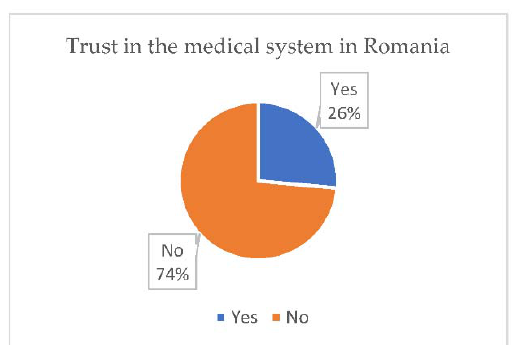
Figure 2. Trust in doctors in România.